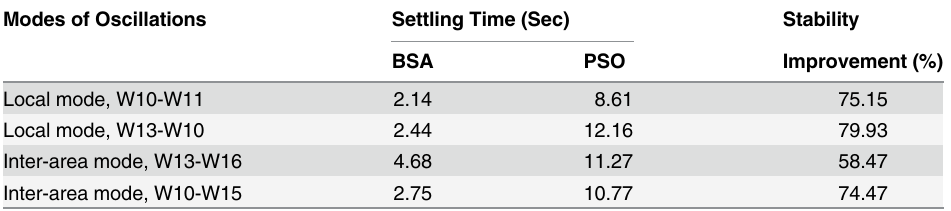
Table 4. System stability improvement in term of settling time for the BSA- and PSO-based designs. Modes of